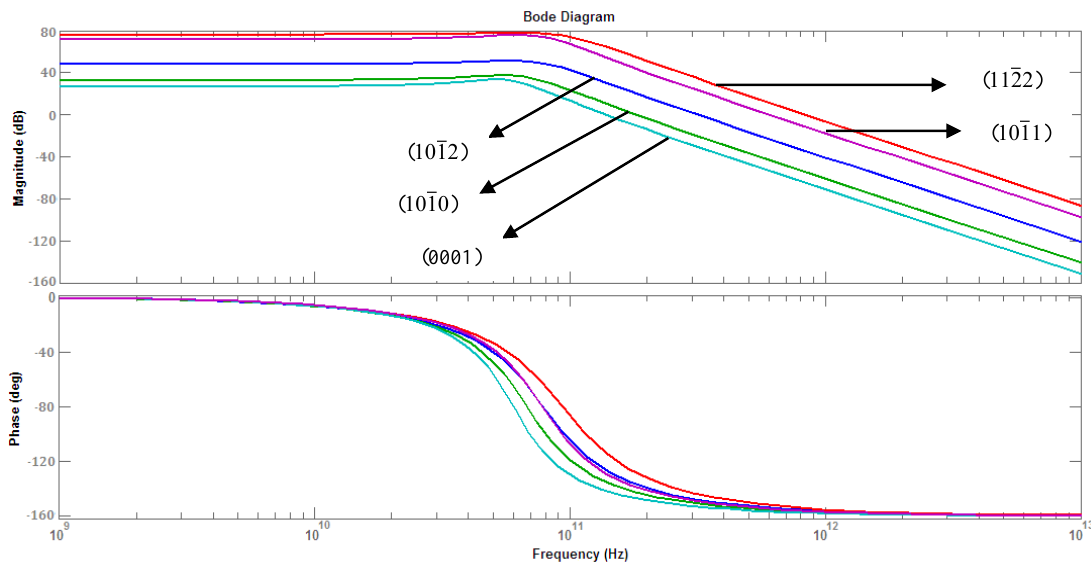
Figure 14. Frequency response of In 0.17 Ga 0.83 N/GaN SQW blue laser in different crystal orientation.